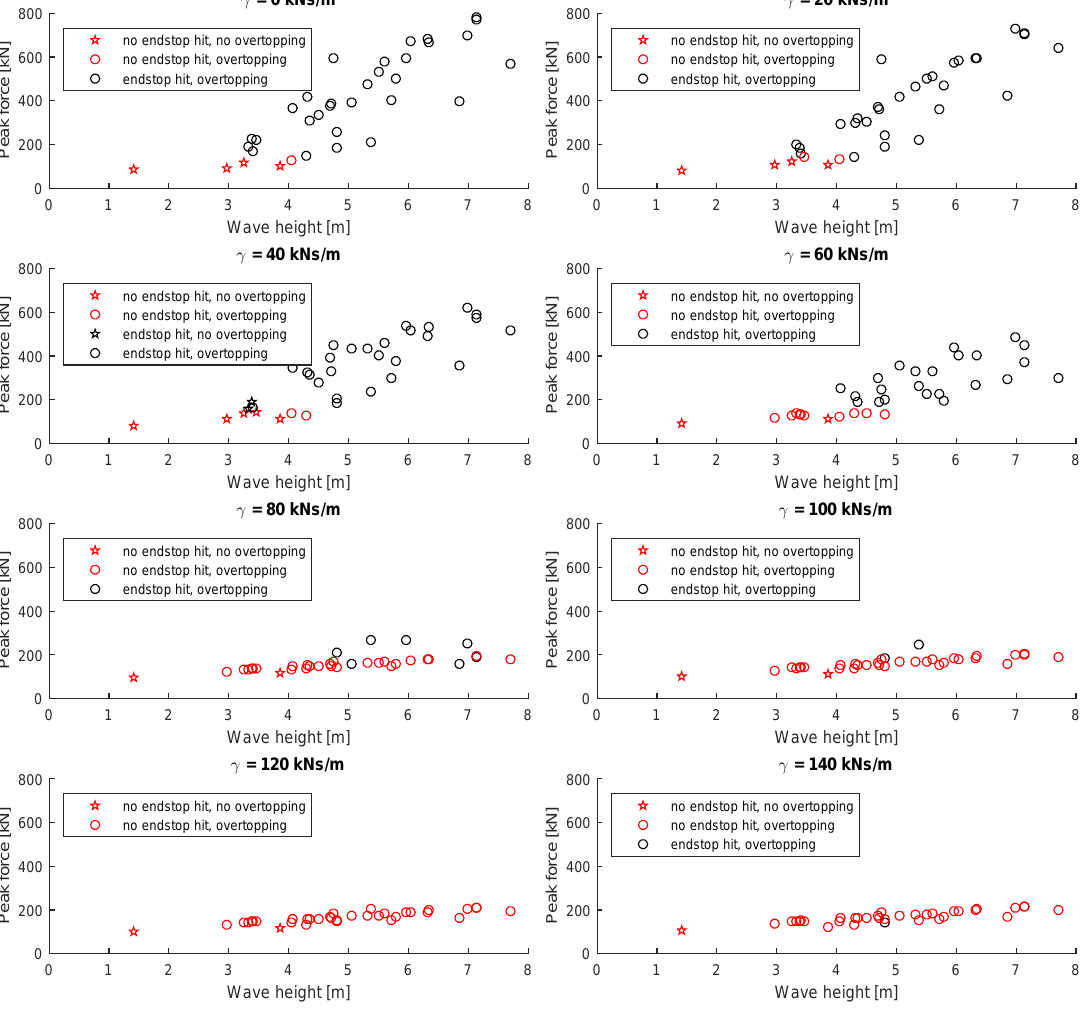
Figure 6. The peak forces plotted as a function of wave height. The peak forces decrease with increasing generator damping for damping factors up to γ = 100 kNs/m. For higher γ , the generator is strong enough to keep the translator from hitting the upper endstop and the peak forces are not further